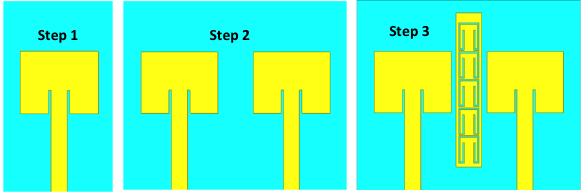
Figure 2. Steps for the design of proposed MIMO antenna.